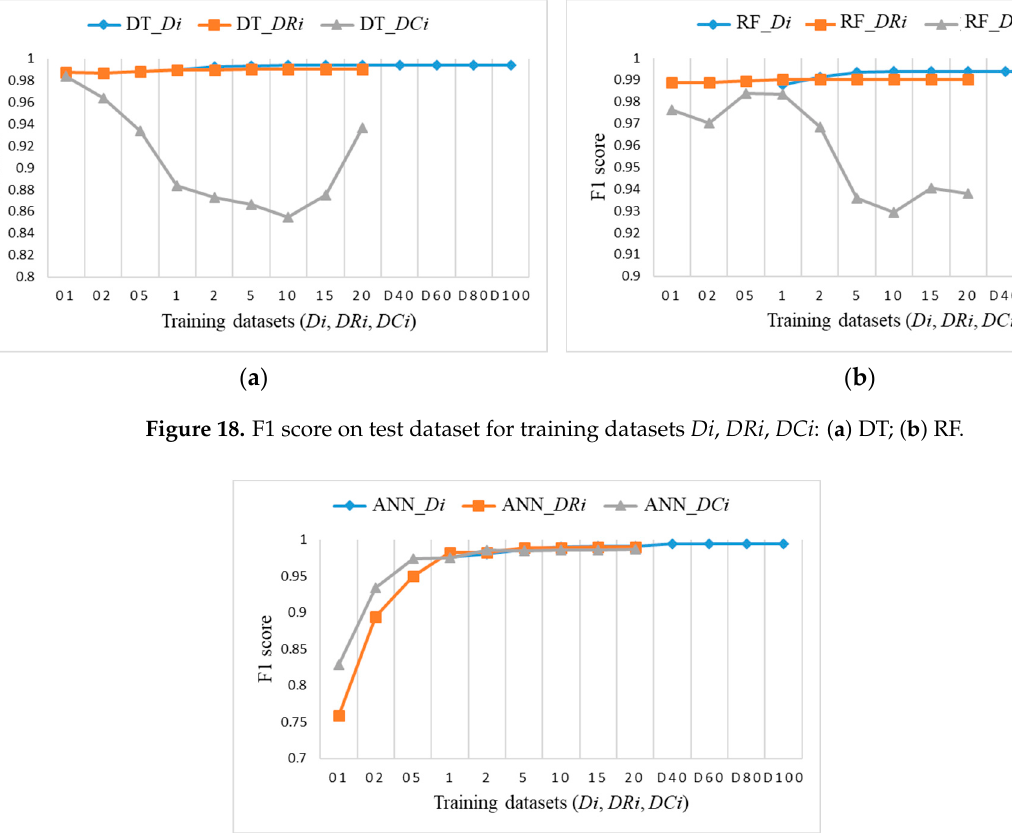
Figure 19. F1 score on test dataset for training datasets Di , DRi , DCi for ANN.